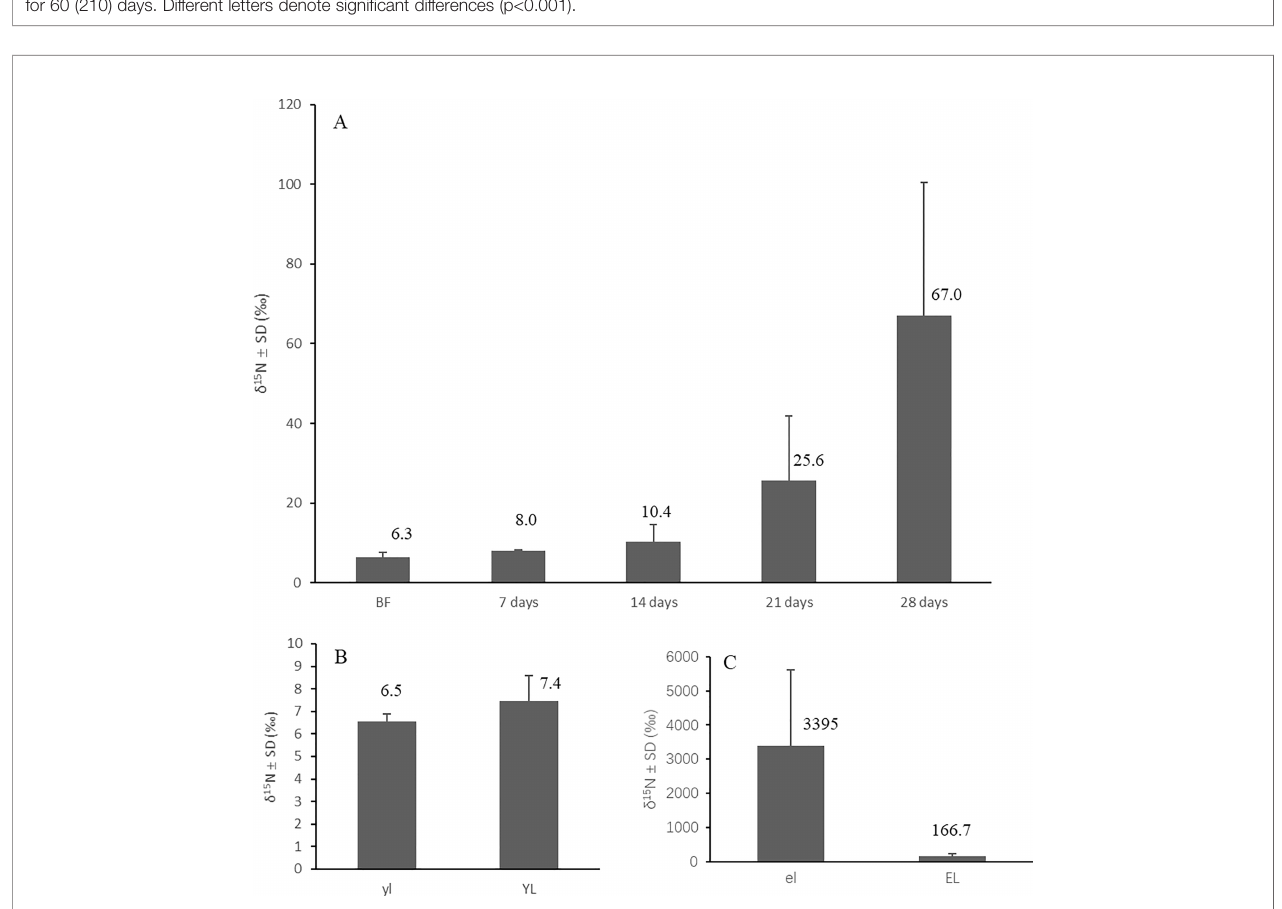
FIGURE 6 | Variation of d 13 C and d 15 N (mean ± SD) of N. smithi after 60 days and 210 days in experiment 4. BF, before feeding; YL-60D (210D), fed yellow leaves for 60 (210) days. Different letters denote signi fi cant differences